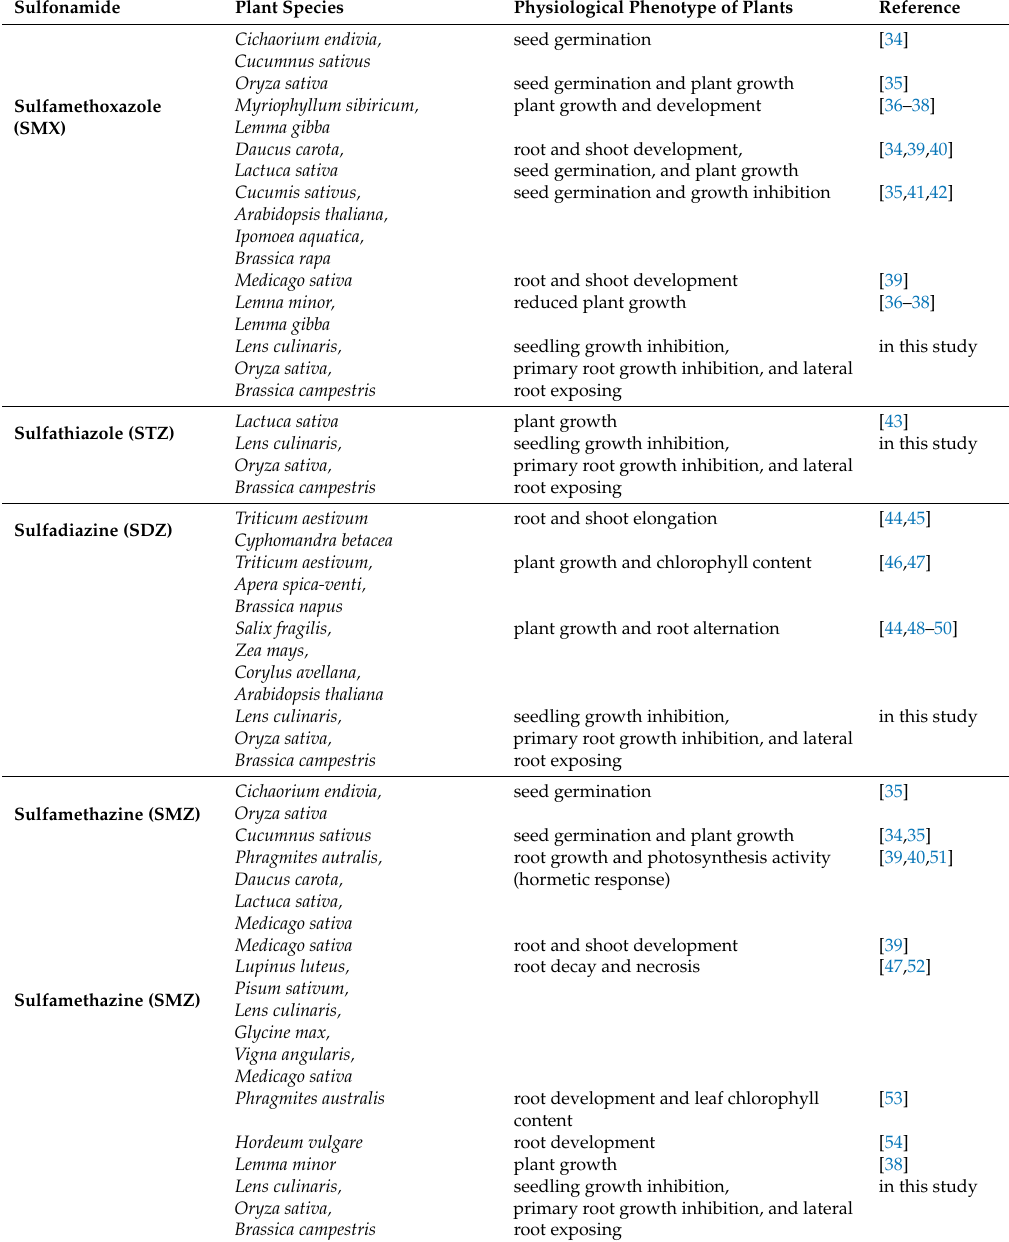
Table 1. The summary of sulfonamides e ff ects on